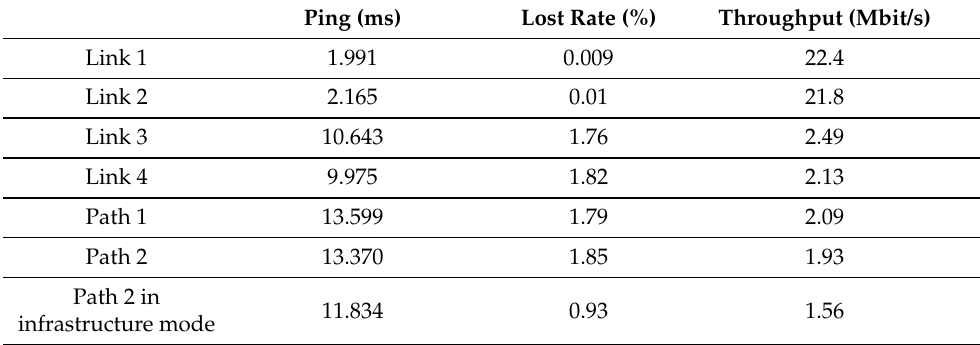
Figure 4. Latency performance between the sender and the receiver. Table 4. Link